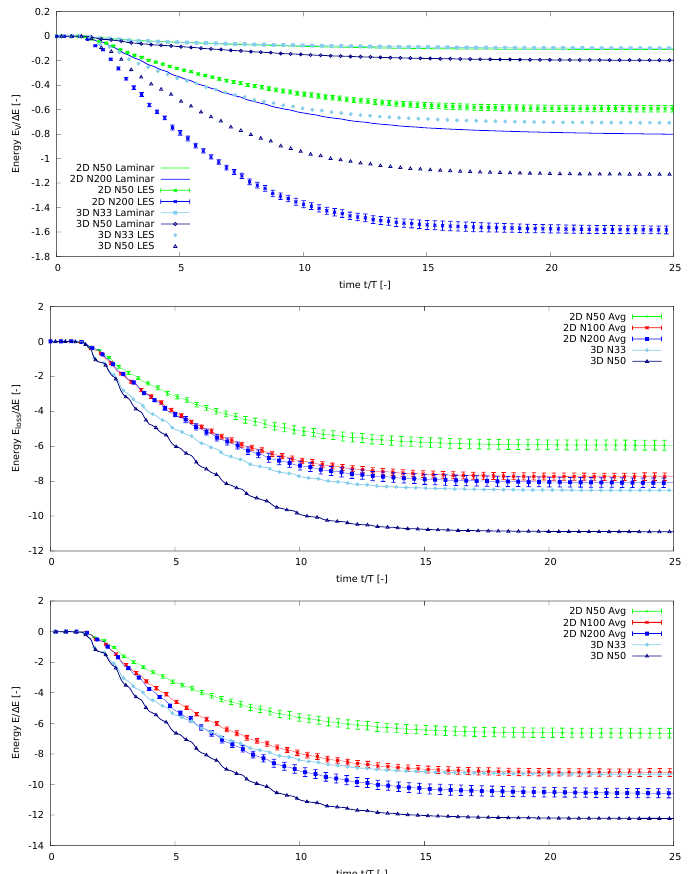
Figure 32. Comparison of energy viscous dissipation ( top ), impact losses ( middle ) and total dissipa- tion ( bottom ) for water.